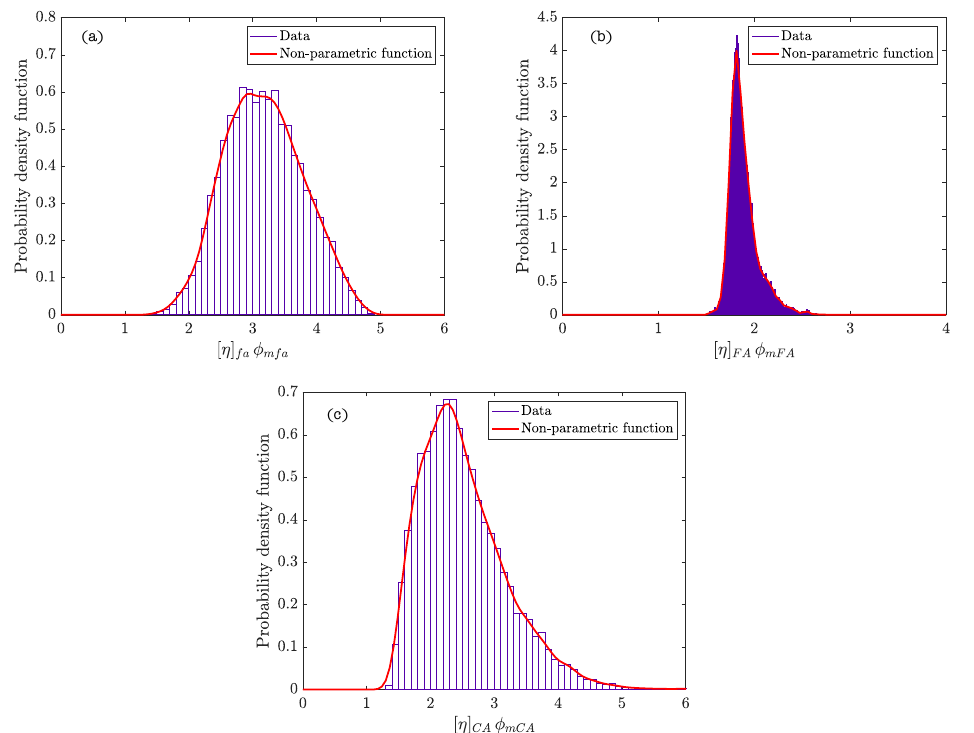
Figure 5. Probability density functions of φ mi [ η ] i (( a ) powder phase; ( b ) fine granular phase; ( c ) coarse granular phase) in SCSFRC ( λ =78.5).